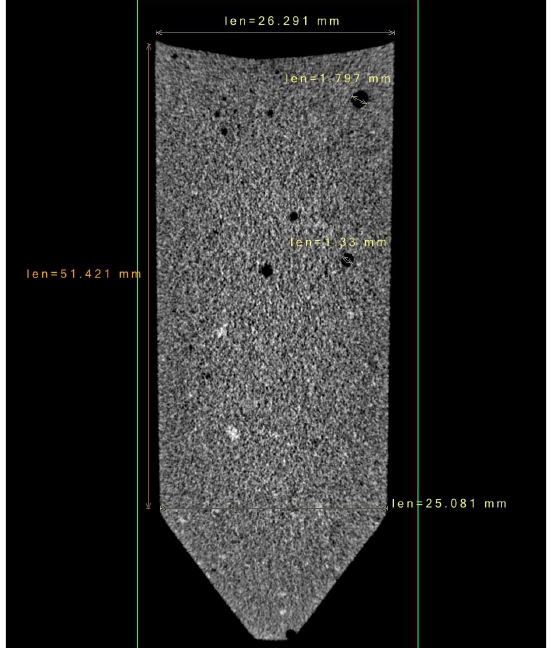
Figure 9. X-ray computed tomography. The scan resolution is 60µm 3